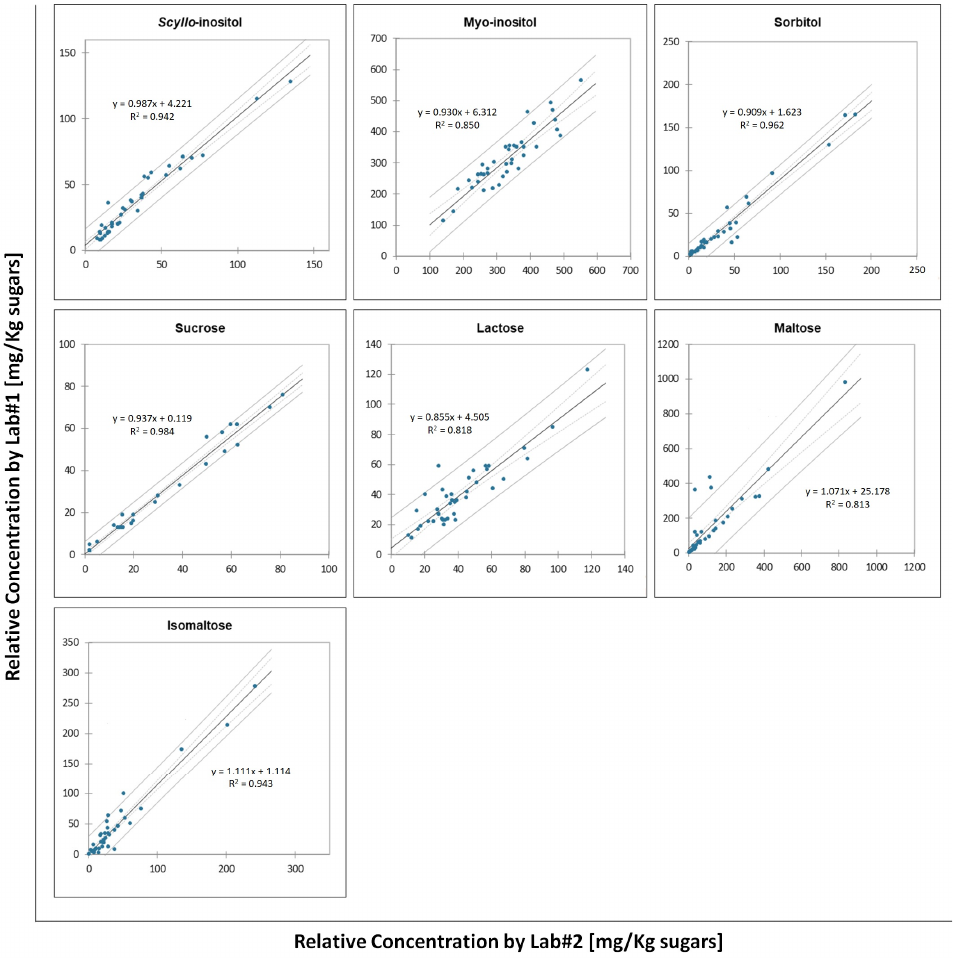
Figure 1. Comparison of the relative concentrations of target compounds analyzed in the 40 comparison samples at each of the two laboratories. The solid grey lines are the confidence limits for the prediction (95%), while the dotted grey lines are the confidence limits for the regression line (95%).